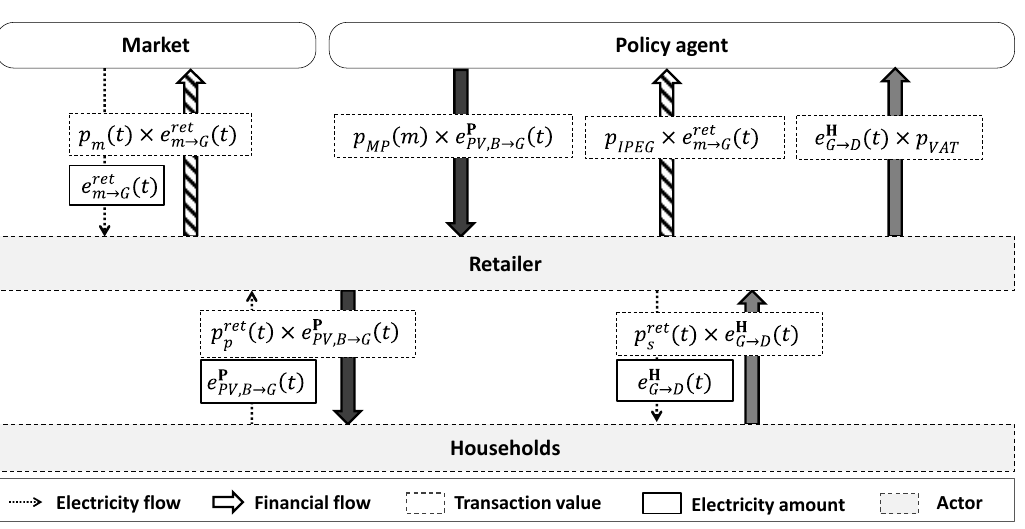
Figure 3. Overview of the regulatory induced financial flows in the model. Arrows with similar patterns or color show related financial flows.